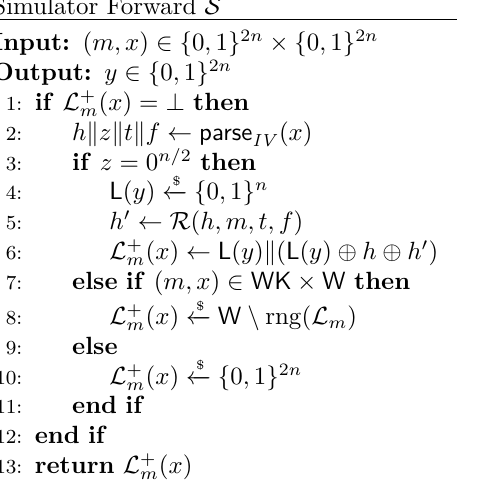
Figure 2: Simulator S for the proof of Theorem